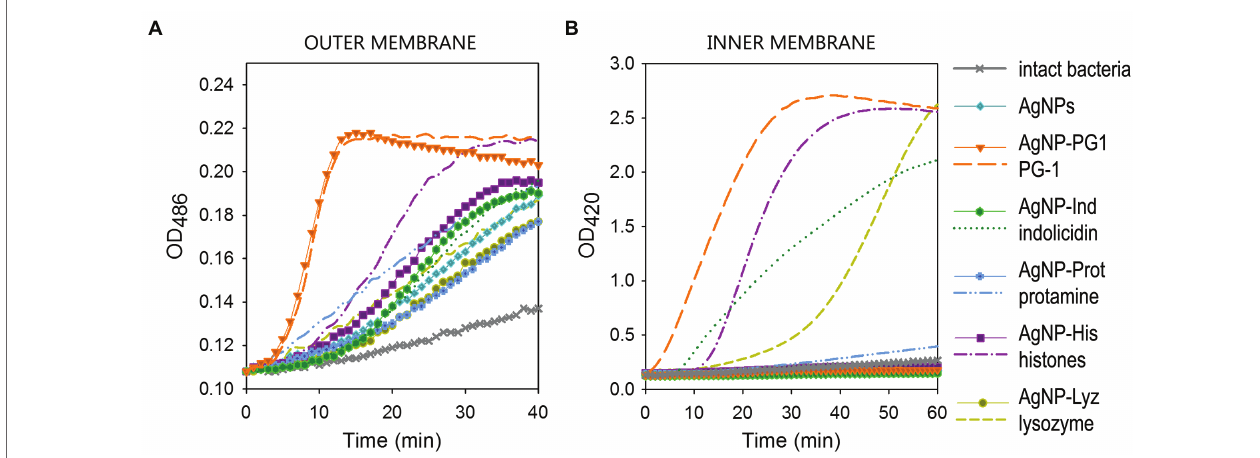
FIGURE 1 | Permeabilizing effect of AgNP-AMP/AP conjugates on Escherichia coli ML-35p outer (A) and inner (B) membranes. The effects of the conjugates are compared to those of the corresponding antimicrobial peptides and proteins (AMPs and APs) and gelatin-only coated silver nanoparticles (AgNPs) alone. The optical density (OD) increase correlates to the hydrolysis of the chromogenic markers by bacterial enzymes. Permeabilization of the outer membrane gives the nitrocefin marker the access to periplasmic β -lactamase, while inner membrane permeabilization gives the o -nitrophenyl- β - D -galactoside marker (ONPG) the access to cytoplasmic β -galactosidase. Bacterial membranes are impenetrable to the markers under normal conditions; hence the dynamics of their degradation allow assessing the scale and velocity of membrane damage inflicted by the tested substances. The concentration of antimicrobials used was equal to 4 × MIC (minimal inhibitory concentration); typical curves are